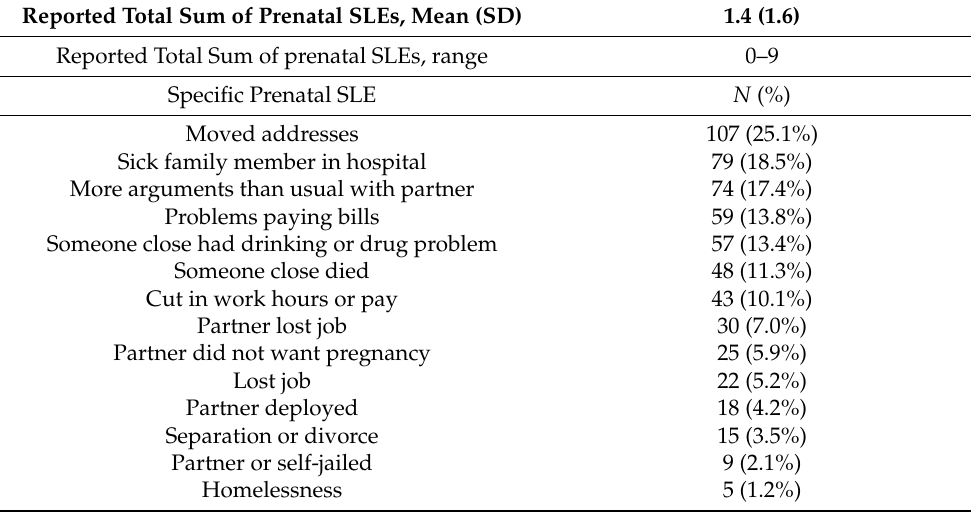
Table 2. Frequencies of maternal report of prenatal stressful life event types by questionnaire item and total